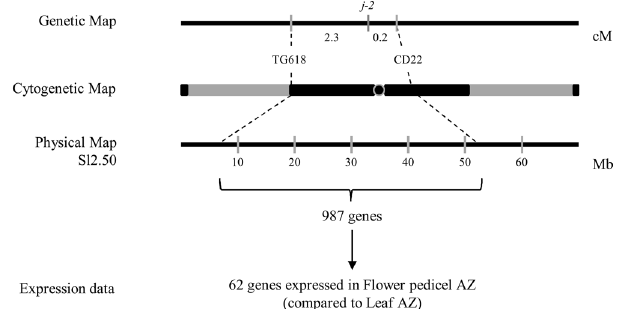
Figure 2. Method used to identify positional candidate genes for j-2 . Representation of TG618 and CD22 markers on the genetic, cytogenetic and physical maps on chromosome 12 of the tomato genome (modified from Budiman M.A. et al . 24 ). Total numbers of annotated genes in TG618-CD22 genetic interval, and of selected genes particularly expressed in flower pedicel abscission zone are also displayed. See the complete list in Supplementary Table